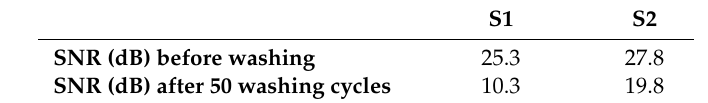
Figure 10. ECG signals, after 50 washing cycles, obtained by ( a ) polyamide textile electrodes coated by S1; ( b ) polyamide textile electrodes coated by S2. Table 2. Signal-to-noise-ratio obtained by polyamide electrodes coated by two PEDOT:PSS solutions.